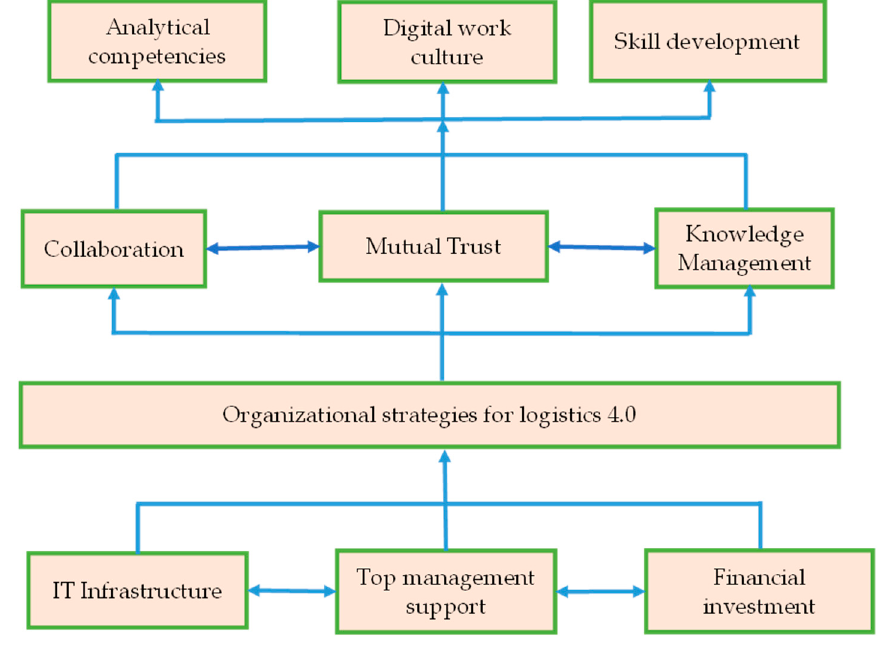
Figure 3. ISM model of determinants of logistics 4.0 adoption. Table 5. Linguistic Scale and their associated TFNs.